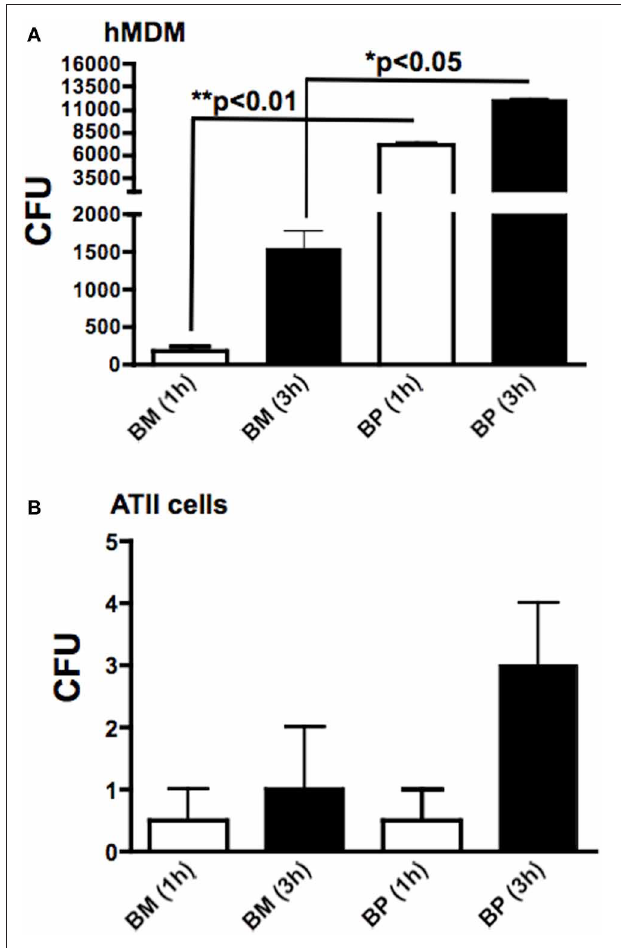
FIGURE 3 | Phagocytosis and intracellular replication of BM and BP . MDM and ATII cells were infected with BM or BP (MOI of 100:1). As determined by CFUs, phagocytosis (accessed at 1h) and intracellular replication (accessed at 3h post-infection) of BP by MDM was significantly higher compared to BM (A) . Alternatively, neither BM nor BP invaded or replicated to high numbers in ATII cells (B) . Data is representative of two experiments containing duplicate conditions/experiment and is represented as mean ± SEM. ∗ denotes significance of p < 0 . 05 and ∗∗ p < 0 . 01.